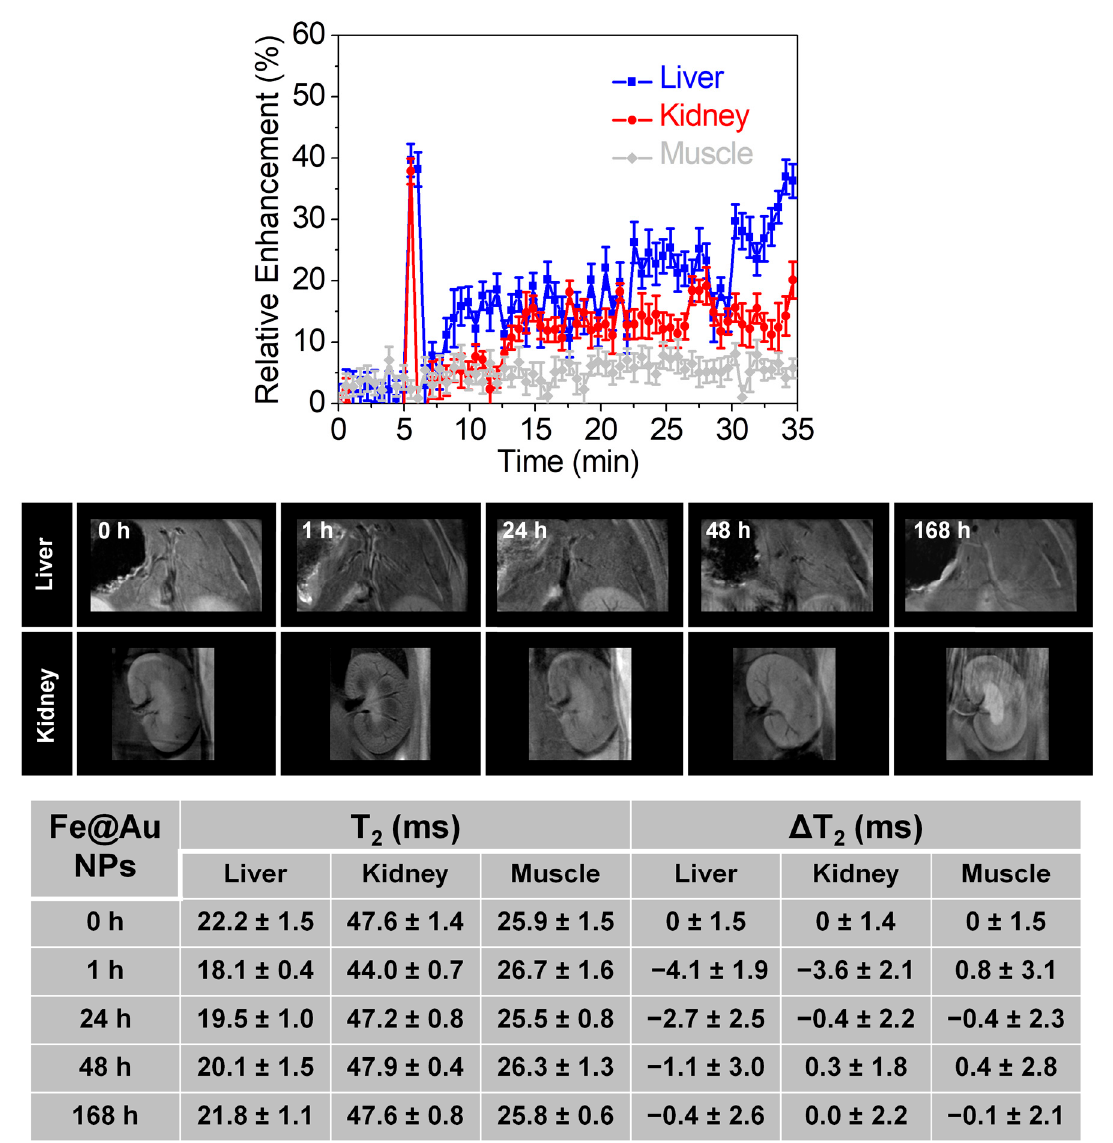
Figure 7. ( top ) In vivo pharmacokinetics after intravenous injection in mice of Fe@Au NPs in the liver (blue), kidneys (red), and muscle (grey). ( bottom ) Representative T 2 -weighted MRI images of liver and kidneys at different time points after the intravenous injection of NPs. The table shows T 2 and Δ T 2 values in the liver, kidneys, and muscle at different time points after the intravenous injection of Fe@Au NPs. Values correspond to the mean ± SD ( n = 3). No significant variation in the RE curve was reported for the muscle, as expected.